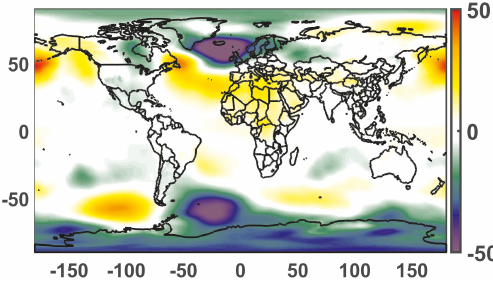
Figure 6. Trends of winter sea level pressure during the 2002–2016 period (Payr − 1